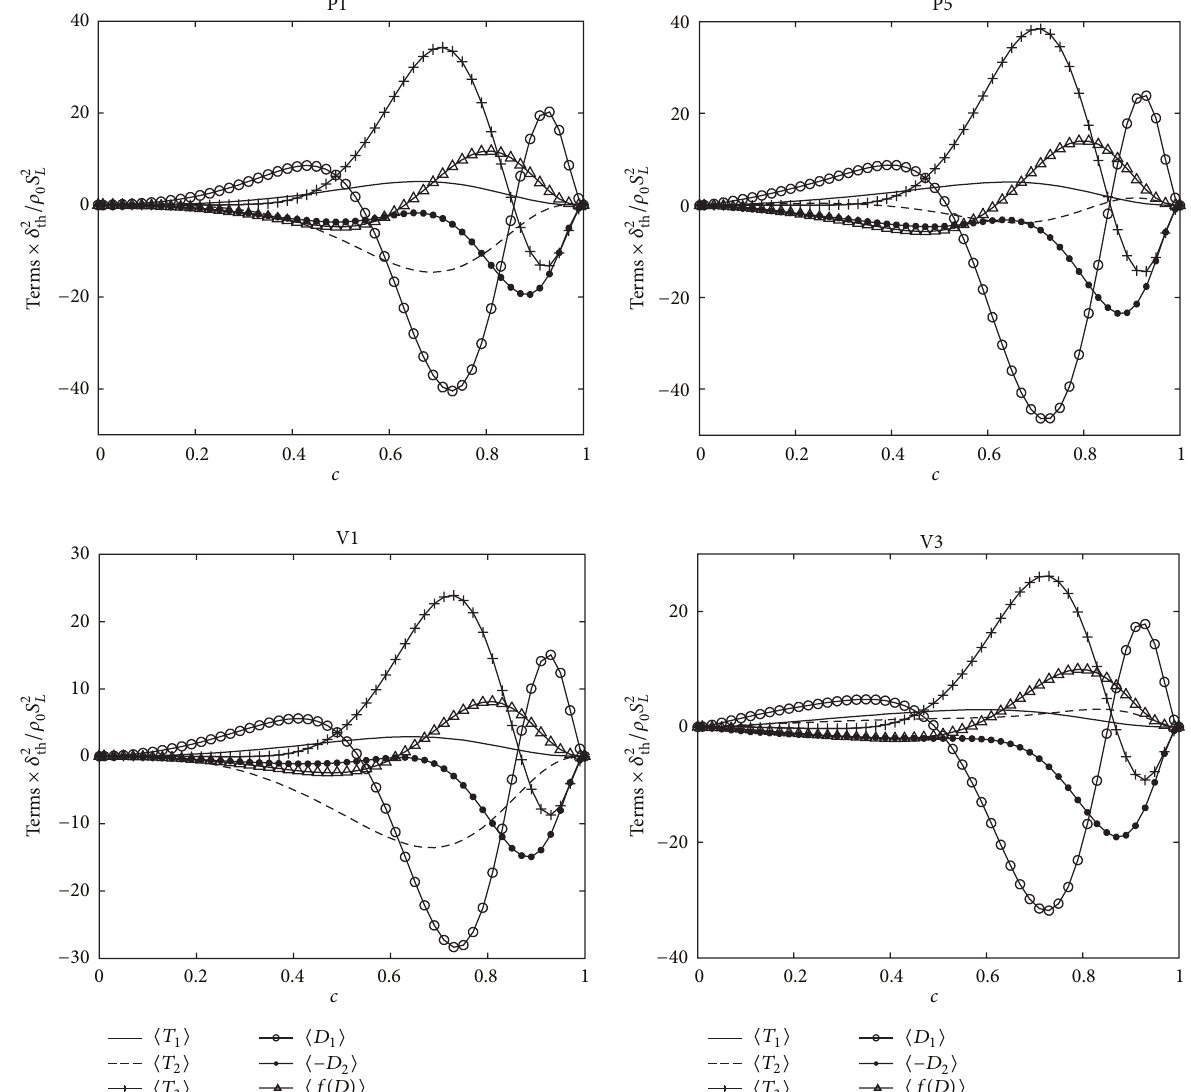
Figure 3: Variation of the mean values of ⟨𝑇 1 ⟩, ⟨𝑇 2 ⟩, ⟨𝑇 3 ⟩, ⟨−𝐷 2 ⟩ , and ⟨𝑓(𝐷)⟩ conditional on 𝑐 values across the flame for cases P1, P5, V1, and V3. All the terms of the transport equation of 𝑁 𝑐 are normalised with respect to the respective values of 𝜌 0 𝑆 2 𝐿 /𝛿 2